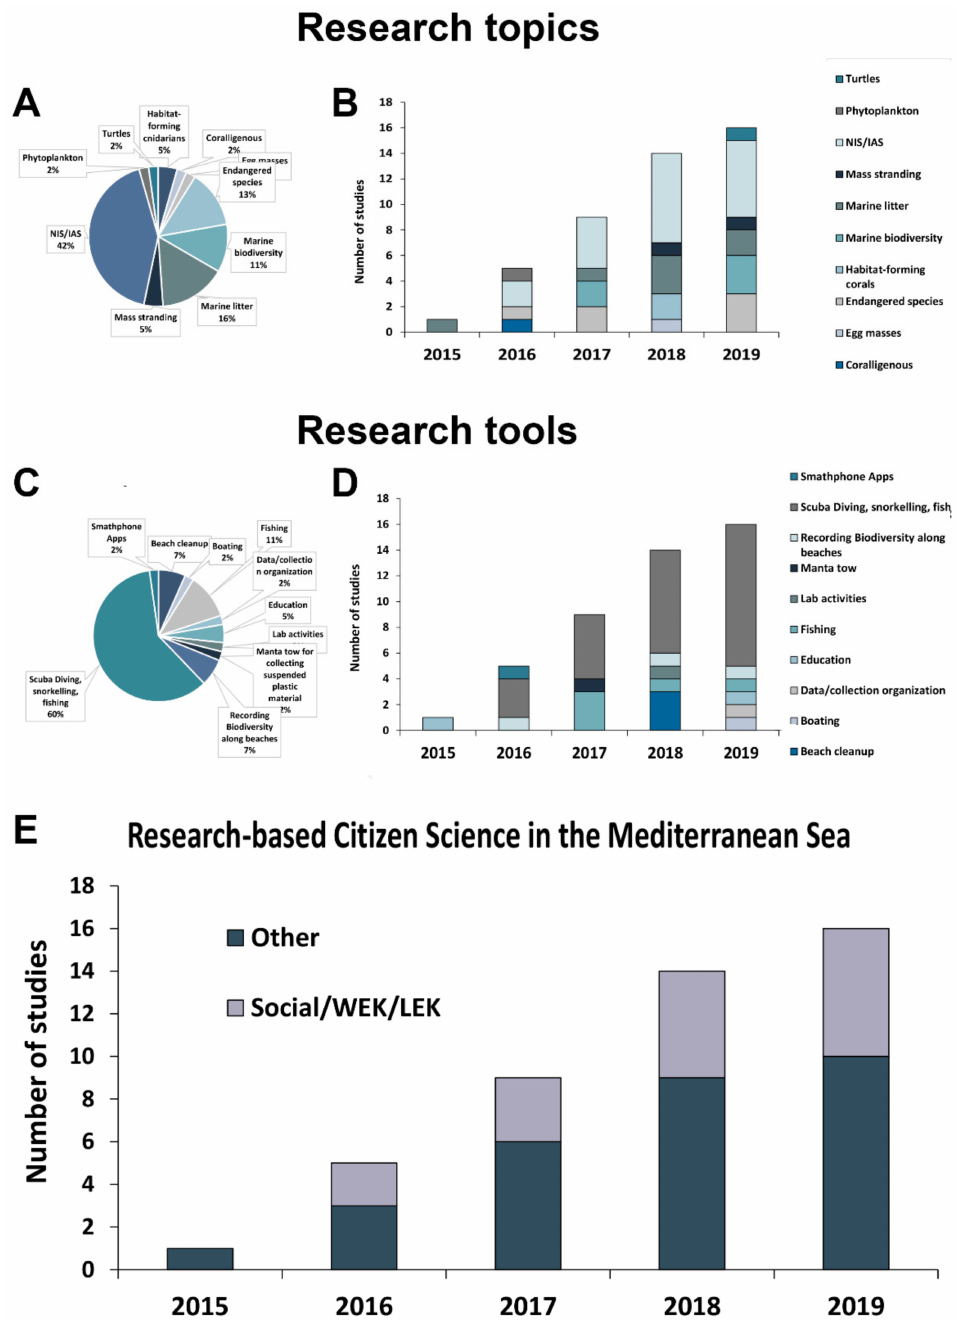
Figure 4. Analysis of citizen science-based studies in the Mediterranean Sea in